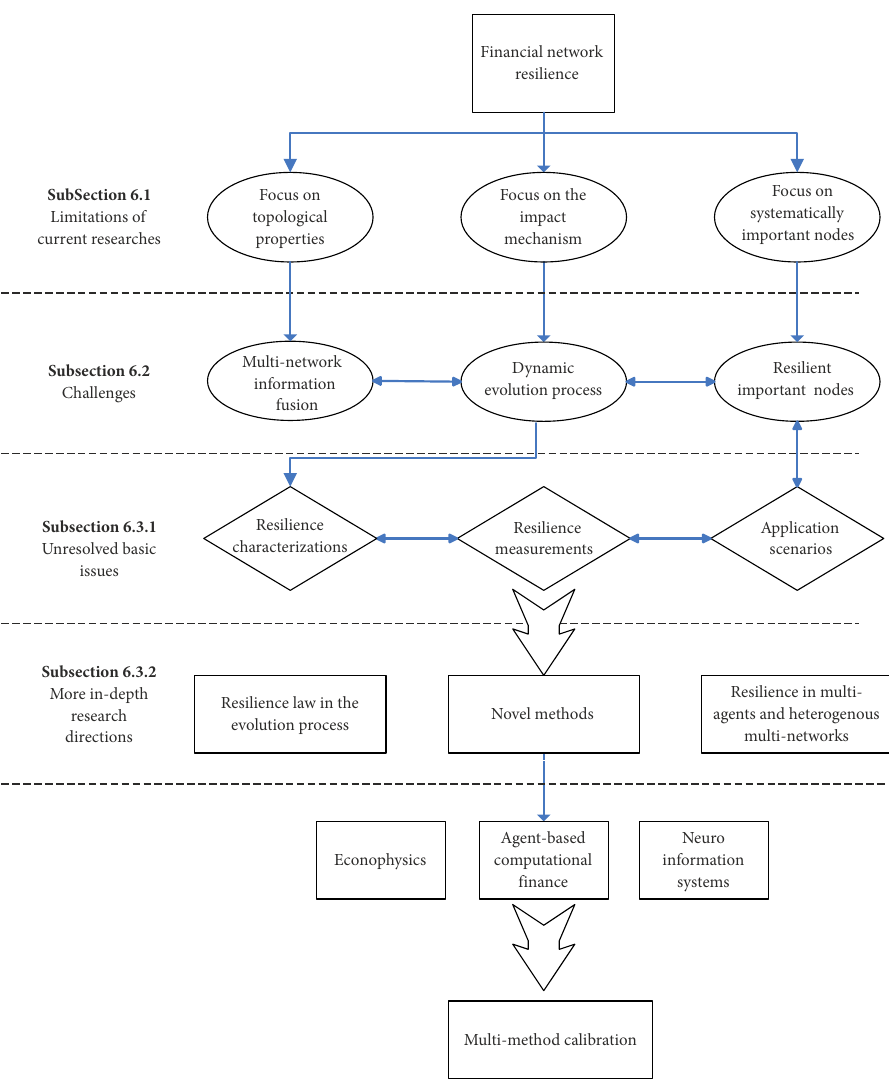
Figure 1. The further research